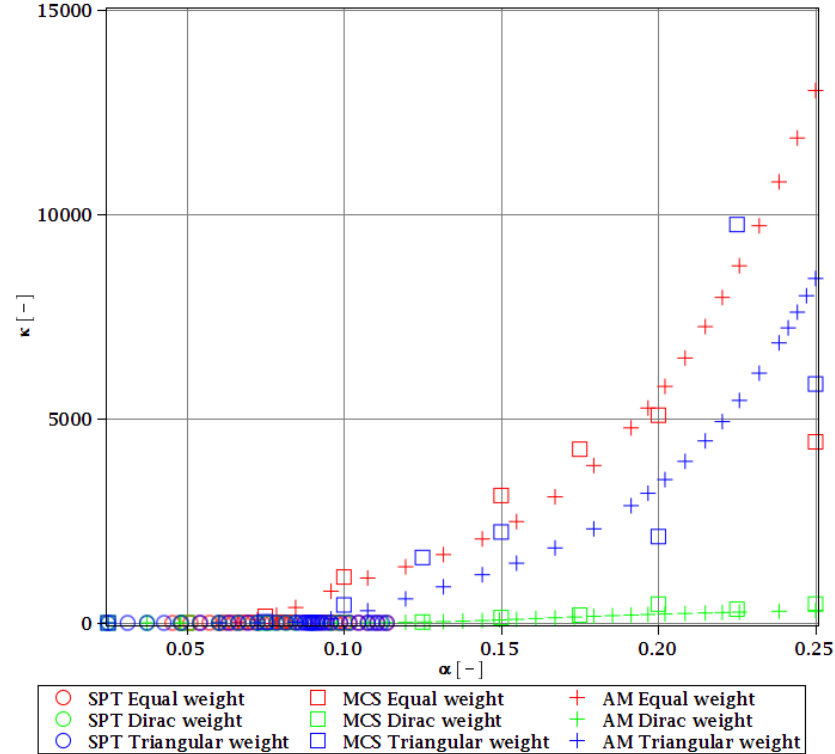
Figure 10. The skewness of the critical load for different types of weights.